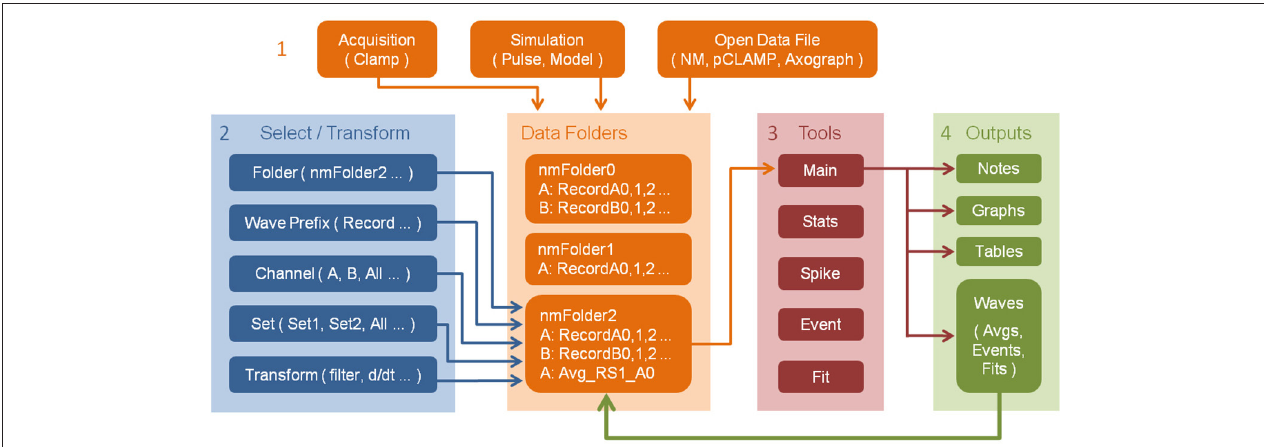
FIGURE 1 | Workflow pattern within NeuroMatic enabling recursive analysis. Numbers denote workflow steps: (1) Work within NeuroMatic begins by either acquiring data via the Clamp tab, computing simulations via the Pulse or Model tab, or opening a pre-existing data file from a disk. The acquired/simulated/imported waves (i.e., time-series arrays) reside inside a NeuroMatic data folder (e.g., “nmFolder0”) and are named with the same wave prefix (e.g., “Record”), followed by a channel letter (e.g., A or B), followed by a sequence number (e.g., 0, 1, 2, etc.). (2) The user selects which data folder, waves, channels and sets to analyze (see Figure 2 ). The